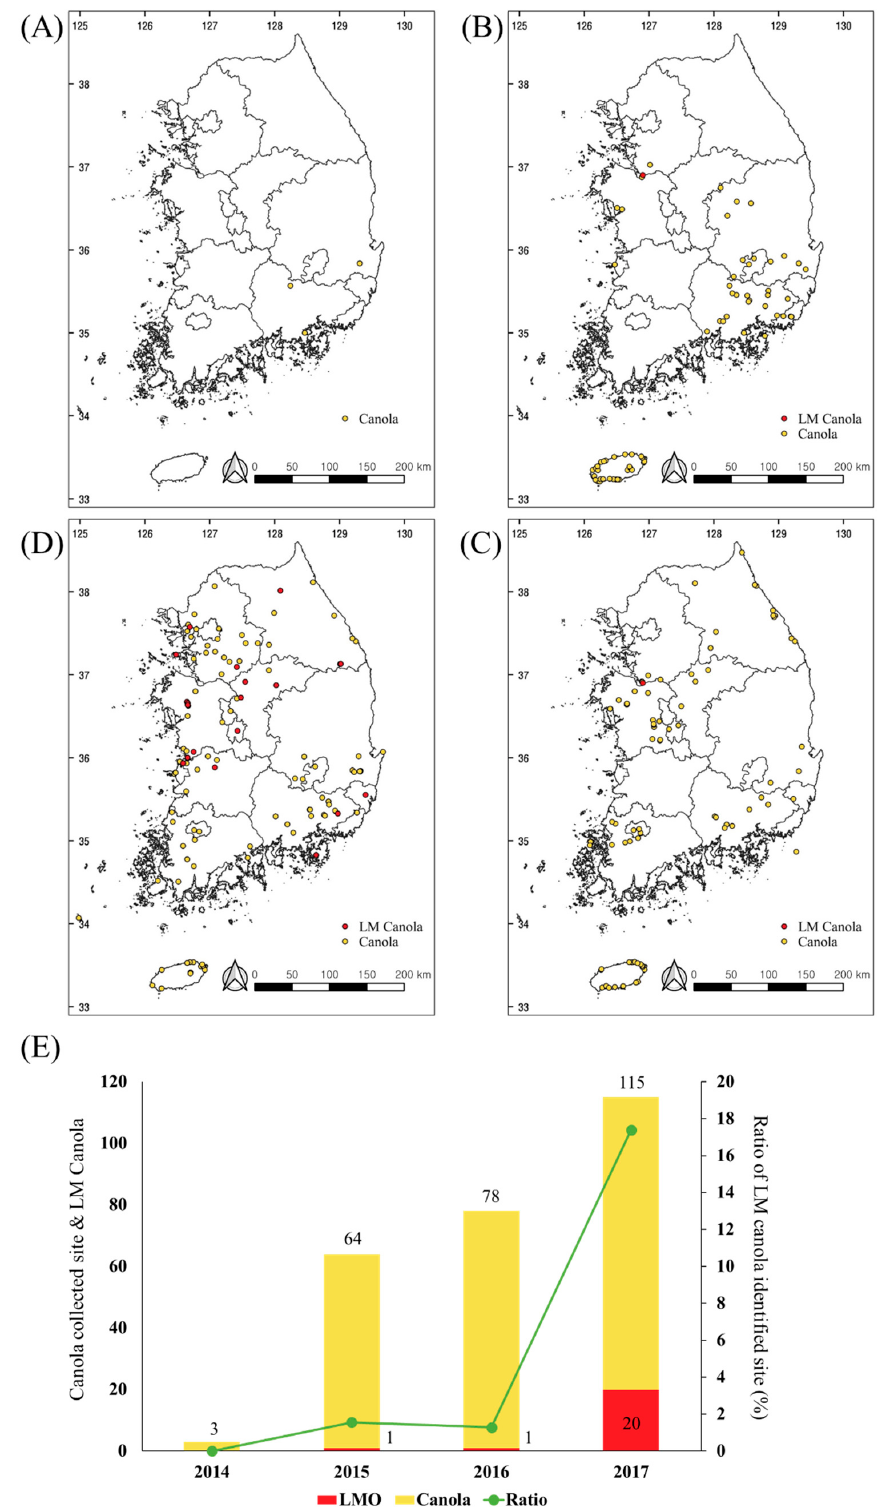
Figure 5. Living modified organism (LMO) identification in the samples collected from 2014 to 2017. The maps show the collection sites of the suspicious canola samples (yellow spot) and the sites of the LM canola (red spot) in 2014 ( A ), 2015 ( B ), 2016 ( C ), and 2017 ( D ). The bar graph presents the number of collection sites for the suspicious samples (yellow) and the LM canola samples (red). The green line shows the ratio of the LM canola identified sites per sample collection site ( E